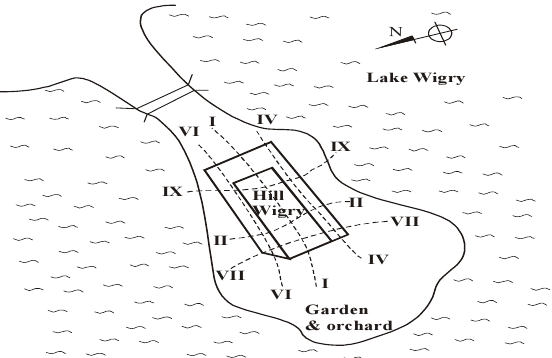
Fig. 3. The Church destroyed during the Second World War